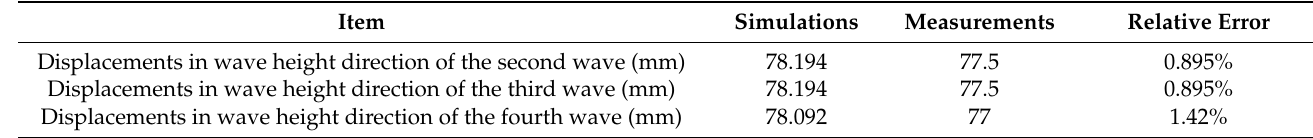
Table 5. Comparison between simulation results and experimental results of the other waves.